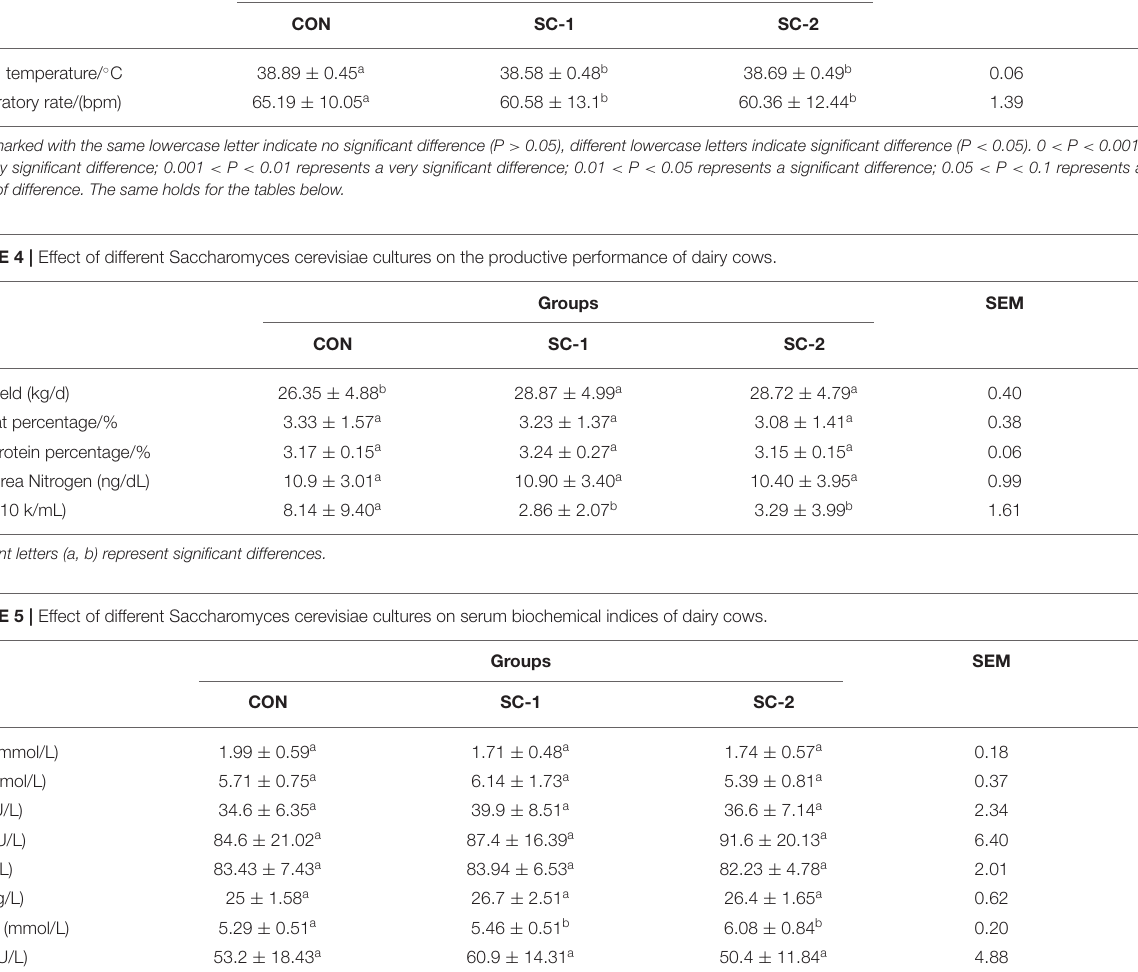
TABLE 3 | Effect of different Saccharomyces cerevisiae cultures on rectal temperature and respiratory rate in dairy cows. Items